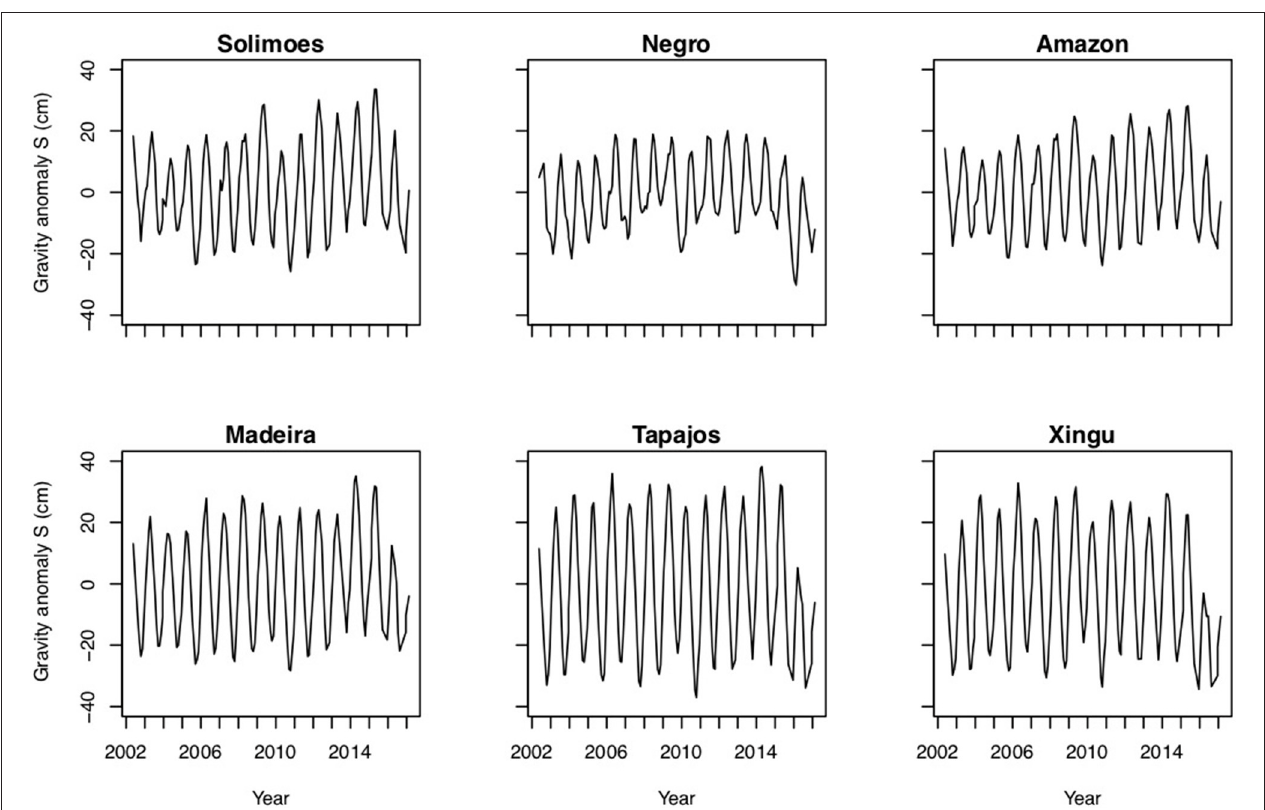
FIGURE 4 | Long-term records of terrestrial water storage anomalies for all